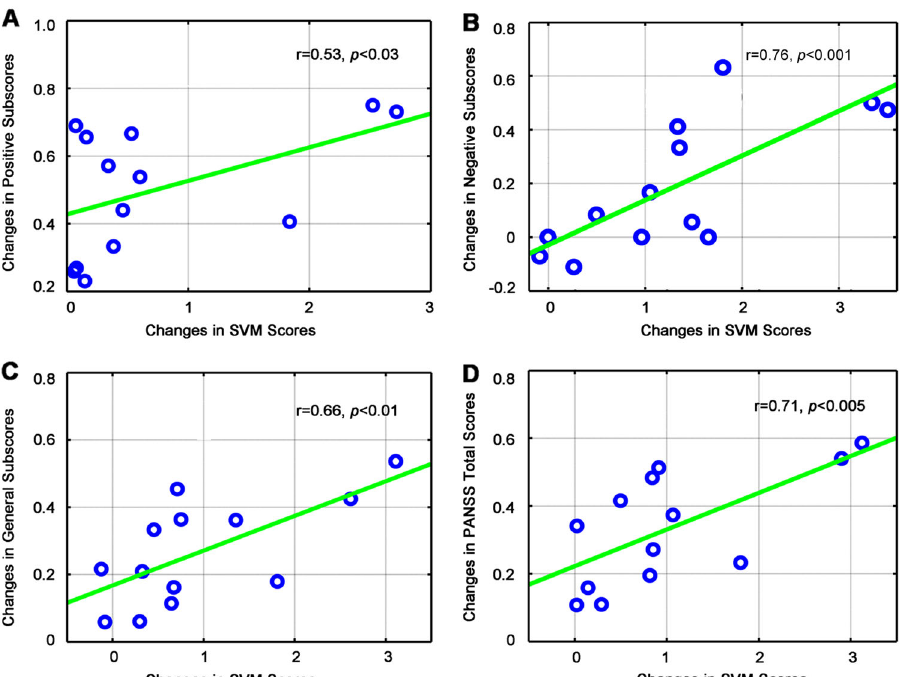
Fig. 3 Changes in aggregate scores associated with improvements in psychotic symptoms after electroconvulsive therapy. Scatterplots show associations between changes in SVM scores and symptom improvement as measured by PANSS positive subscores ( a ), PANSS negative subscores ( b ), PANSS general subscores ( c ), and PANSS total scores ( d ). A positive relationship was found between a reduction of psychosis and aggregate scores. This pattern was mirrored by improvements in psychosis, in which these networks showed a signi fi cant decrease in functional connectivity. SVM support vector machine, PANSS positive and negative syndrome